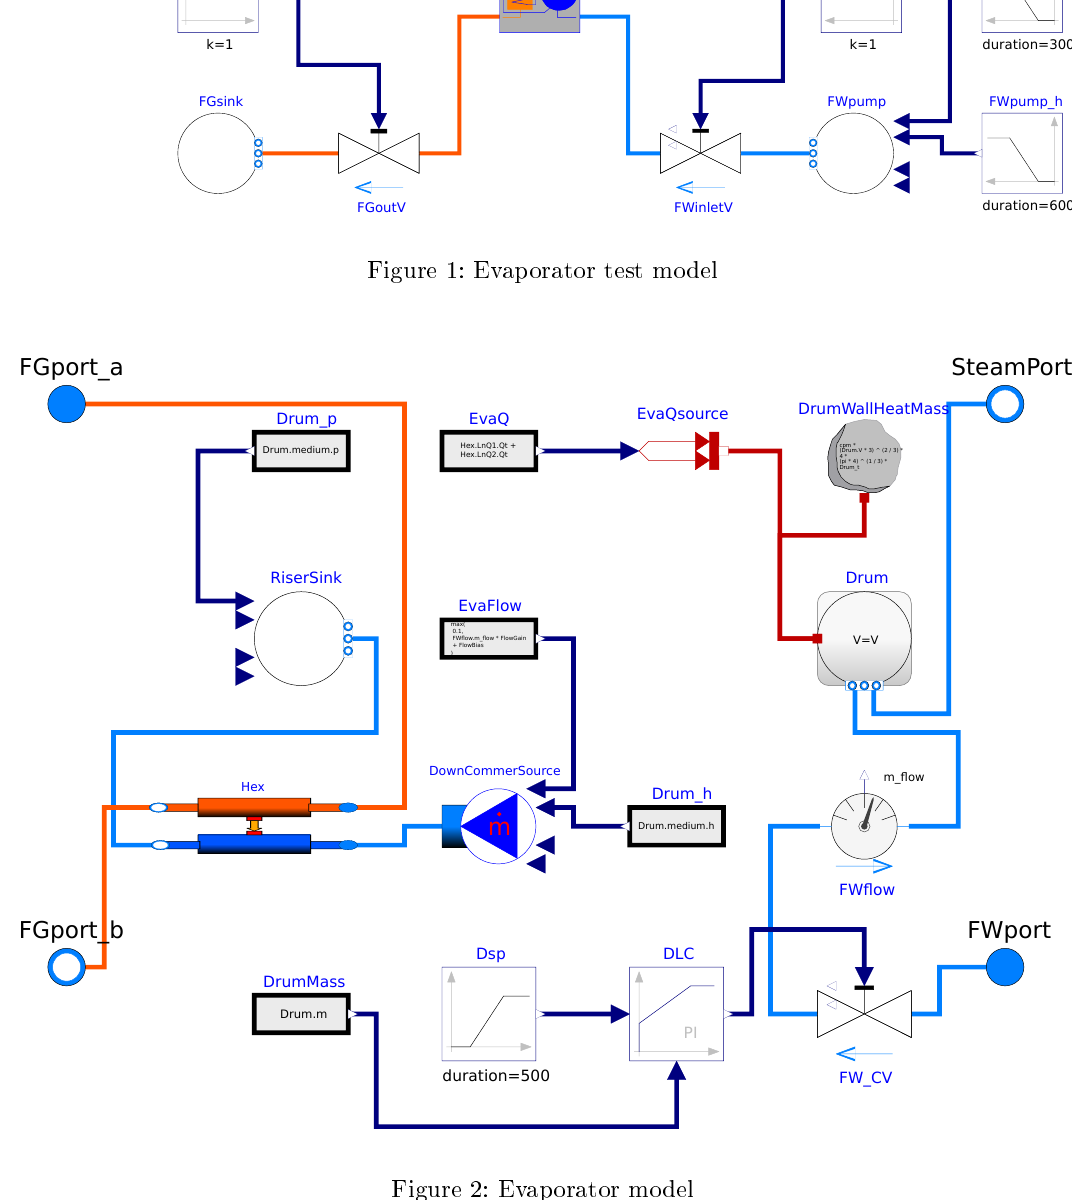
Figure 2: Evaporator